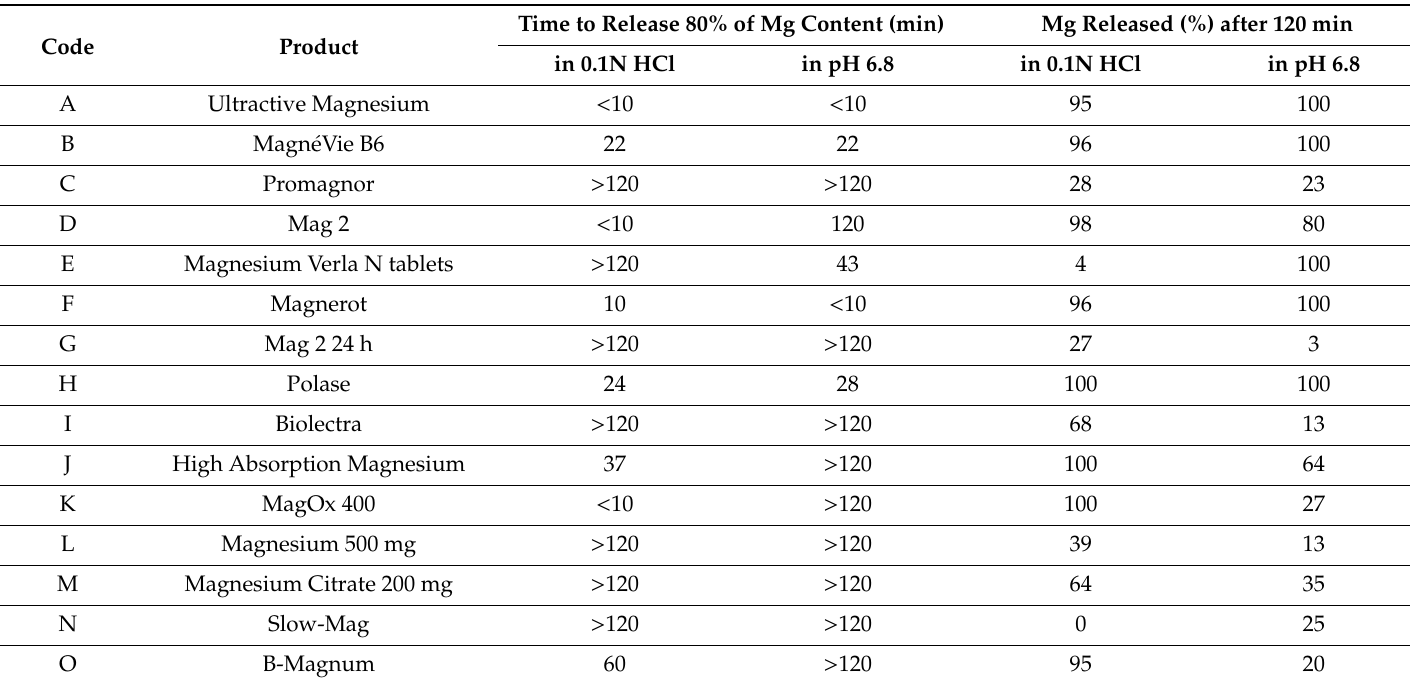
Table 2. Dissolution rates expressed as time to release 80% of Mg content and % release of Mg after 120 min for the 15 di ff erent Mg